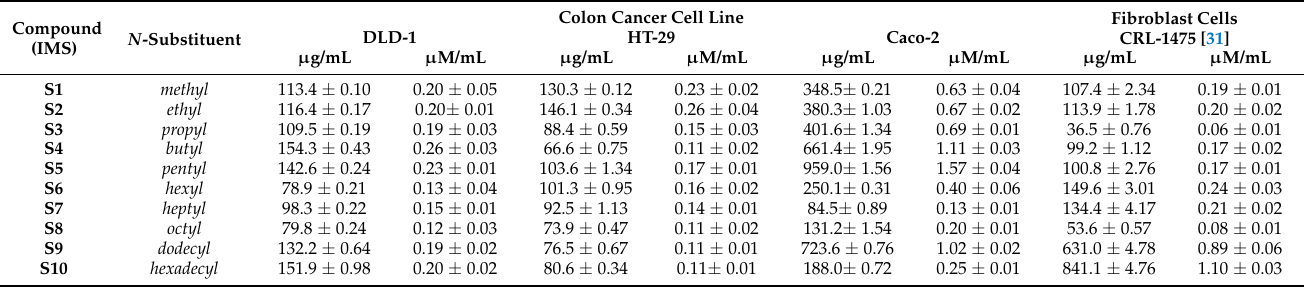
Table 1. Cytotoxic activity of imidazolium salts ( S1 – S10 ) in vitro